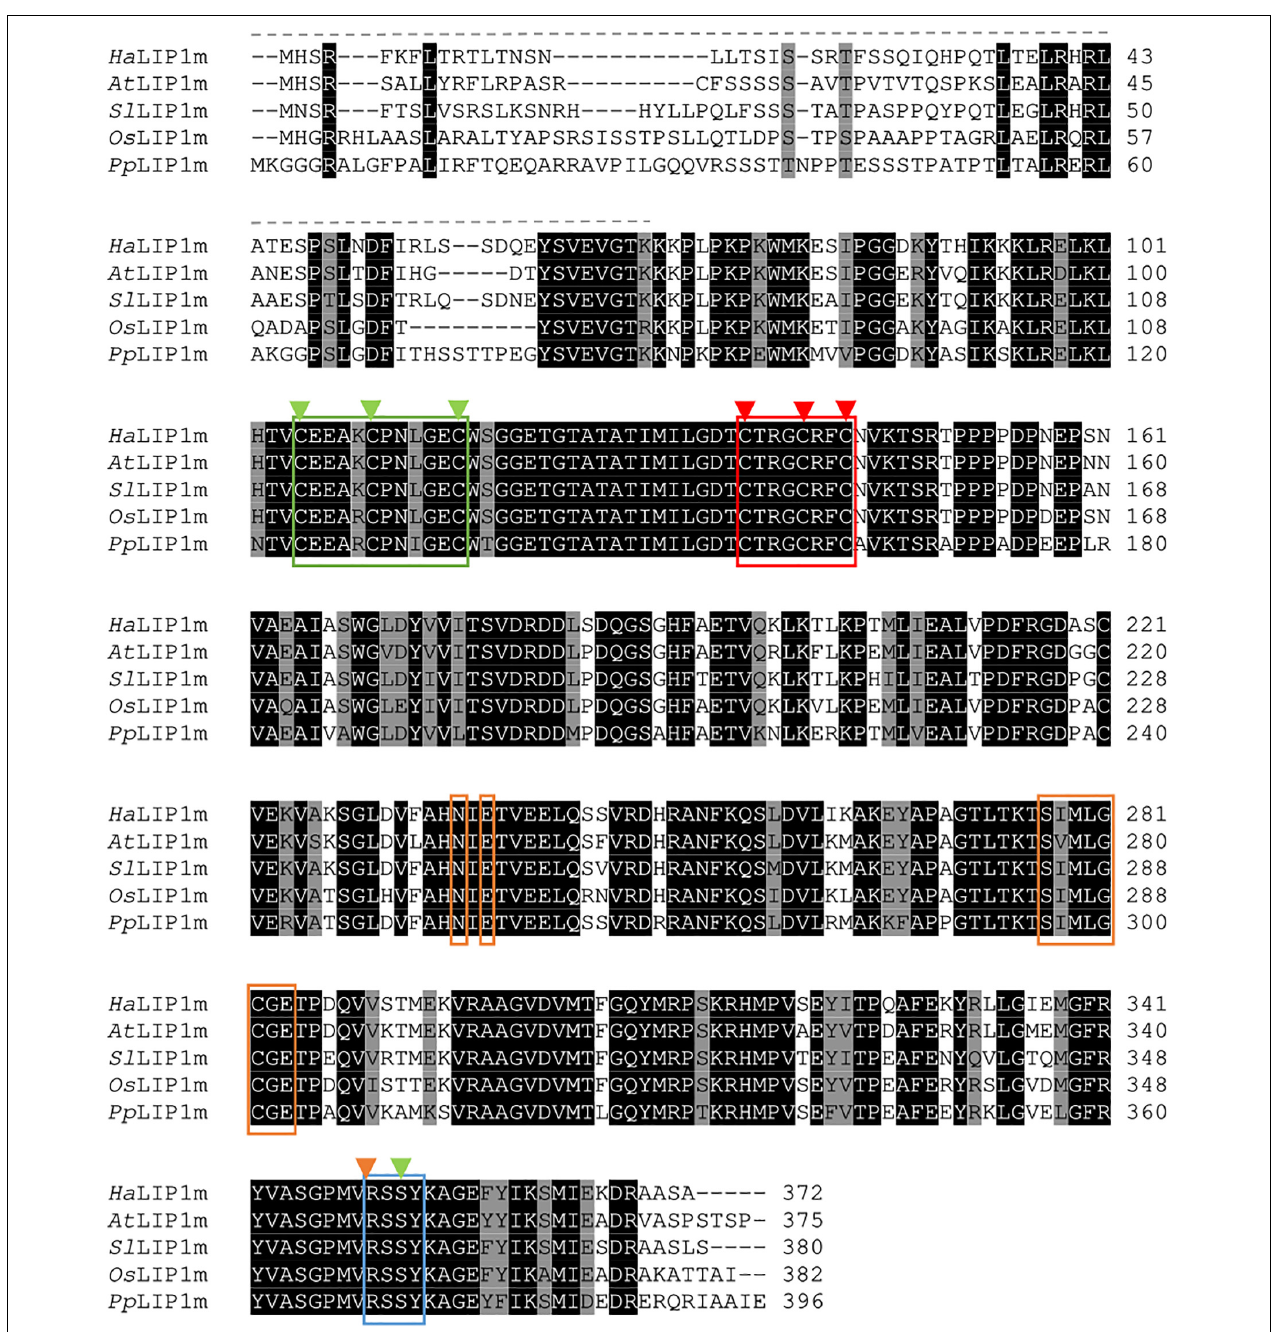
FIGURE 4 | Alignment of the sunflower lipoyl synthase ( Ha LIP1m) aa sequence with homologous proteins from Arabidopsis thaliana ( At LIP1m; OAP07537.1); Solanum lycopersicum ( Sl LIP1m; XP_004243321.1); Oryza sativa ( Os LIP1m; XP_015633364.1); and Physcomitrella patens ( Pp LIP1m; XP_024391419.1). Strictly conserved residues are highlighted in black and highly conserved residues in gray. The signal peptide sequence is indicated with a dashed line and the [4Fe–4S] clusters that participate in the catalytic activity of LIP1 are marked by a red (RS cluster involved in SAM cleavage) and green box (auxiliary cluster with the Ser residue that also coordinates this cluster marked with a green arrow). The conserved R(S/T)S motif in the C-terminus is marked by a blue box. The residues involved in SAM recognition are in orange boxes (Asn and Glu in the ribose motif, and the “GXIXGX 2 E” motif-like characteristic of RS enzymes) and with an orange arrow